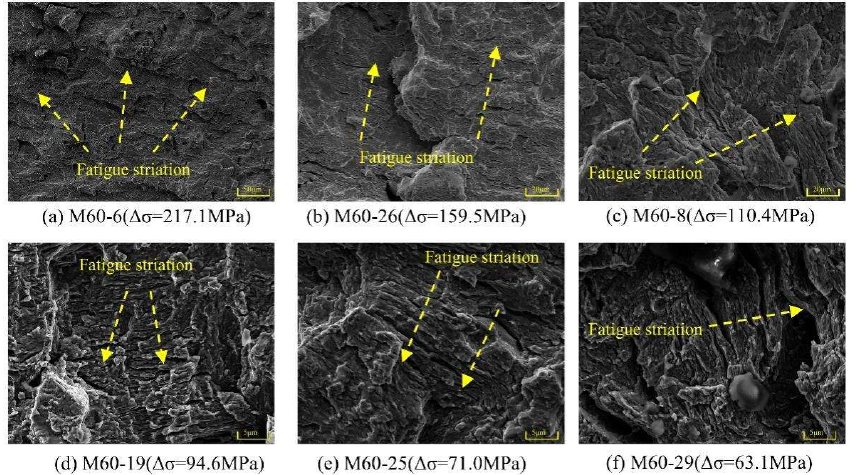
Figure 13. The microscopic morphology of the fatigue propagation area under different stress am- plitudes.